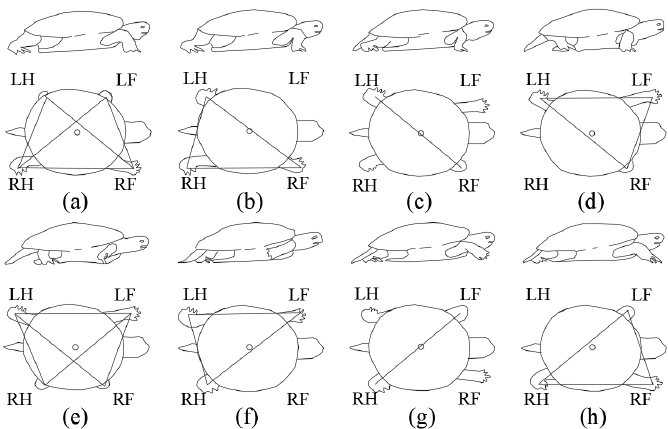
Figure 8. The eight crawling stages of a tortoise. ( a ) Before the LF moves, ( b ) the LF vacated, ( c ) before the RH moves, ( d ) the RH vacated, ( e ) before the RF moves, ( f ) the RF vacated, ( g ) before the LH moves, and ( h ) the LH vacated.